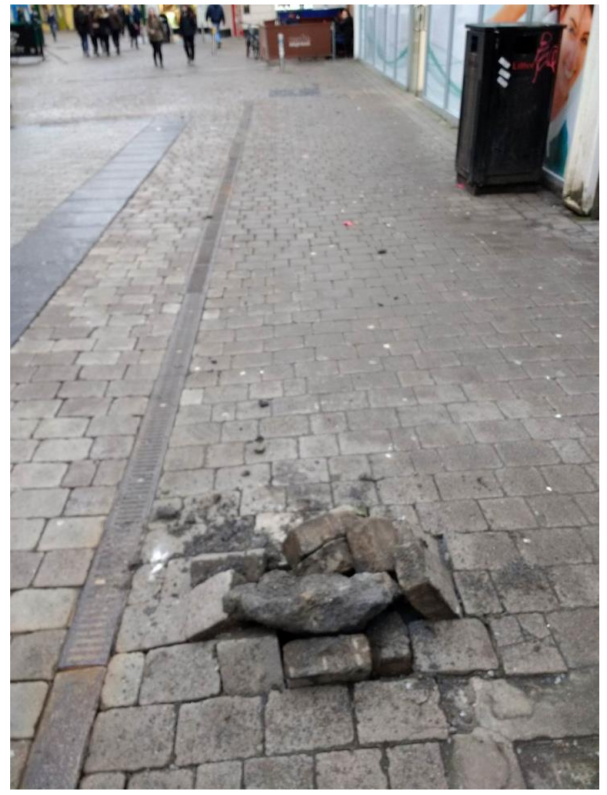
Figure 13. Shop Street, Galway.